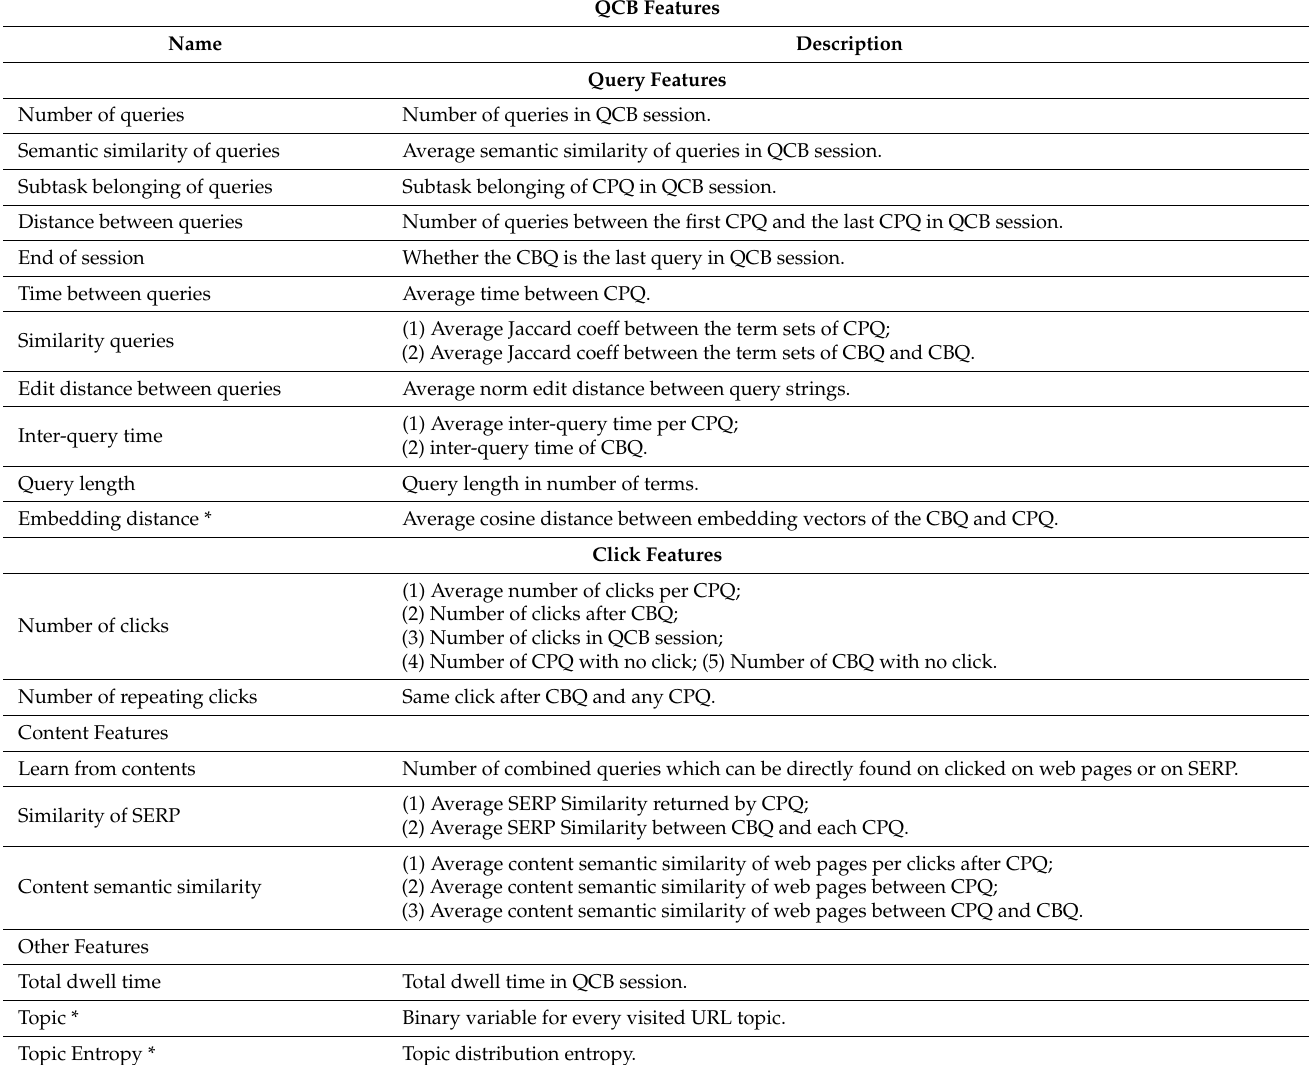
Table 3. Features used for automatic QCB